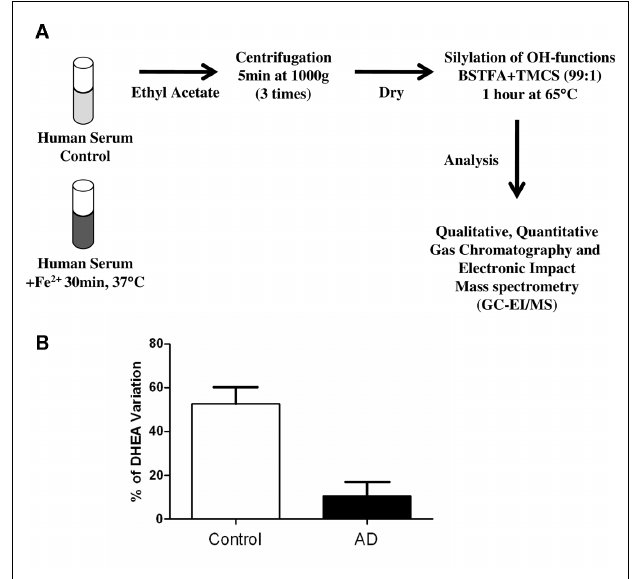
FIGURE 4 | Outline of the methodology used to determine serum DHEA levels and formation in response to FeSO 4 treatment (A). Variation of DHEA levels before and after Fe 2 + oxidation of human sera from AD and age-matched control patients (adapted from Rammouz et al.,